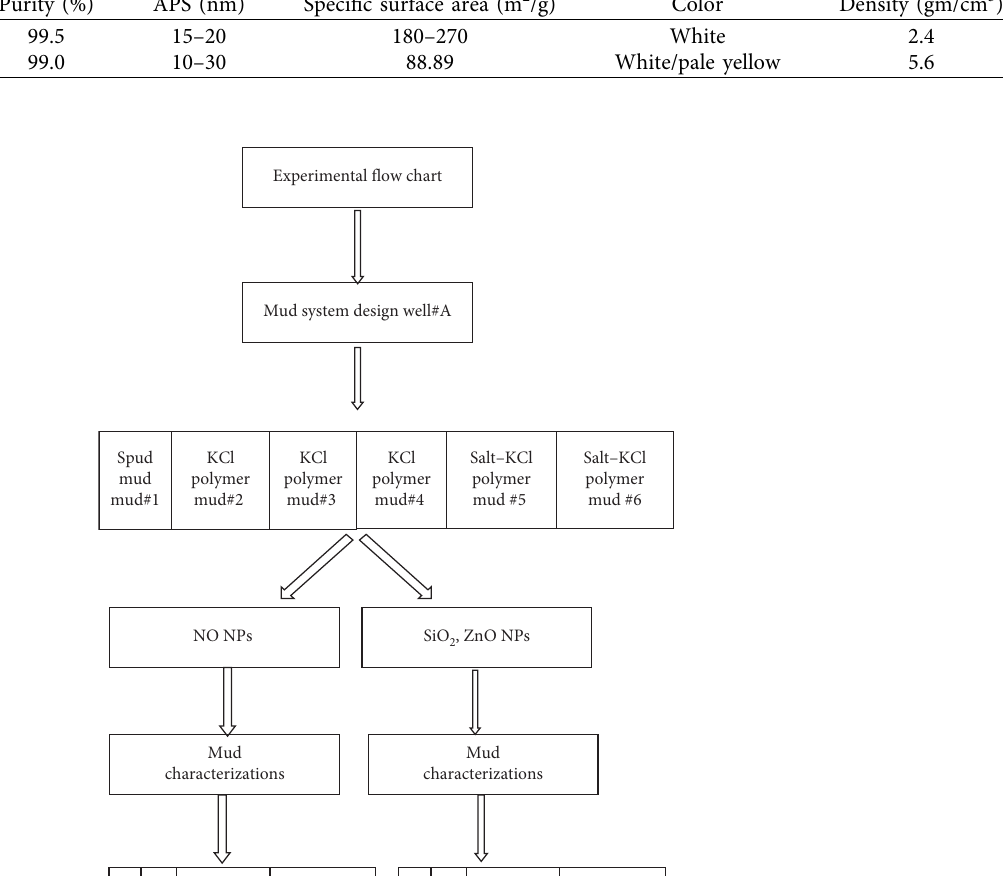
2 and ZnO nanoparticles.